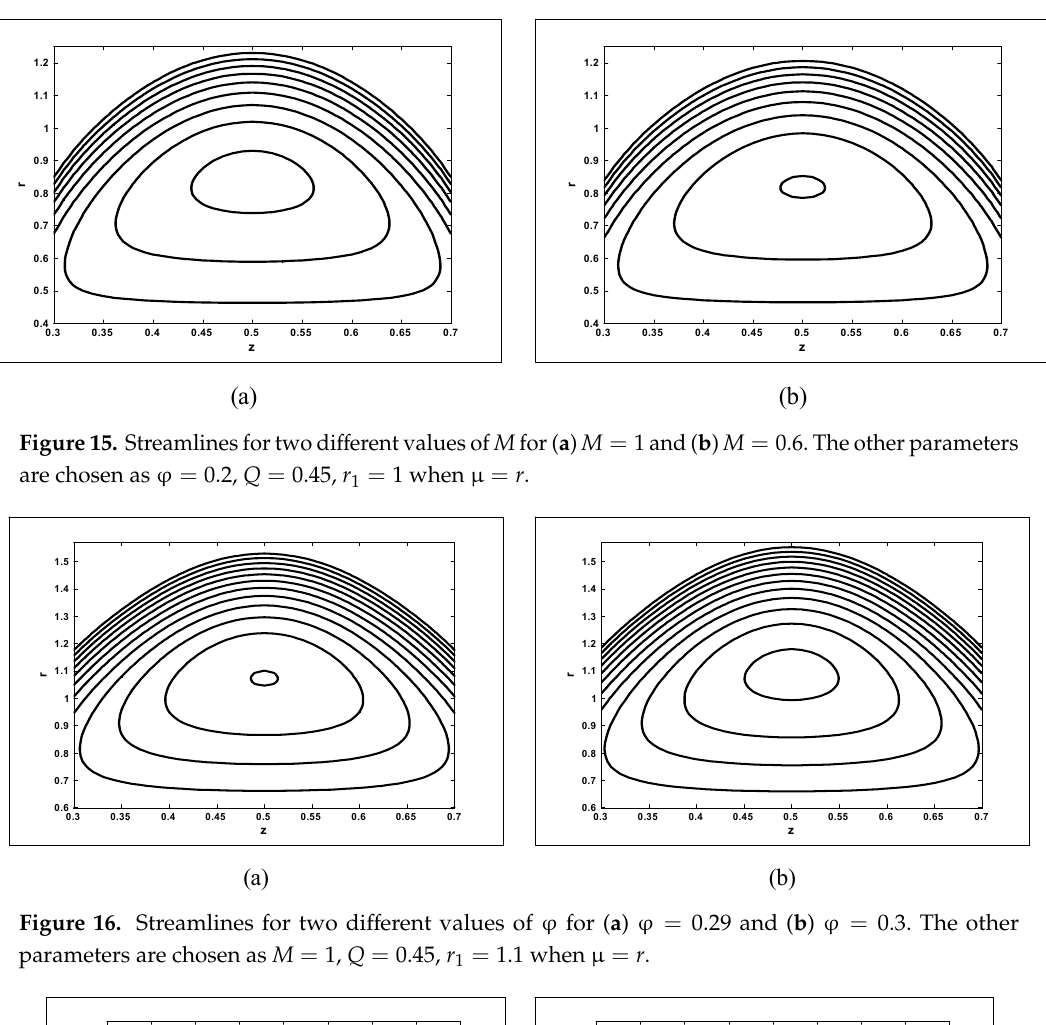
Figure 14. Streamlines for two different values of φ for ( a ) φ 0.1 parameters are chosen as ,2